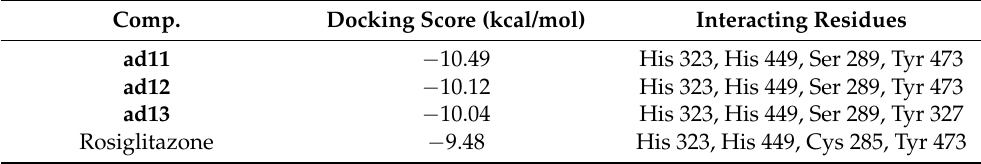
Table 35. Aldose reductase inhibitory activity of the compound ad14. Comp.